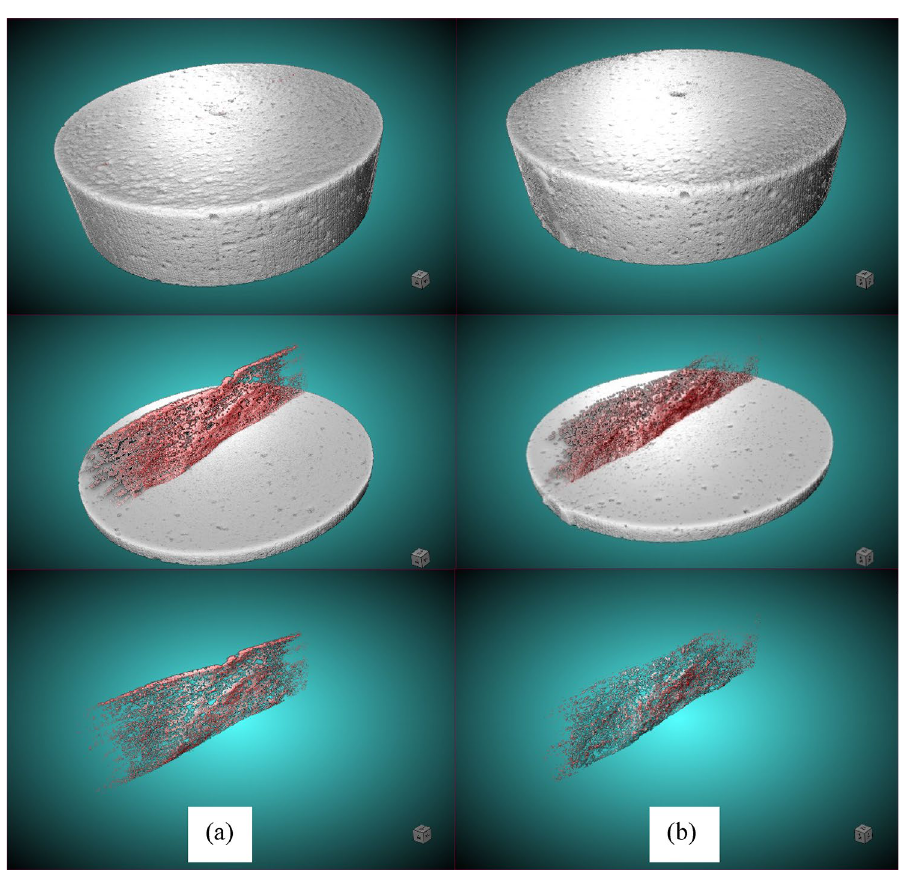
Figure 11. X-ray µCT scan images for FA20 specimen submerged in water depicting: ( a ) before process of self- healing, and ( b ) after process of